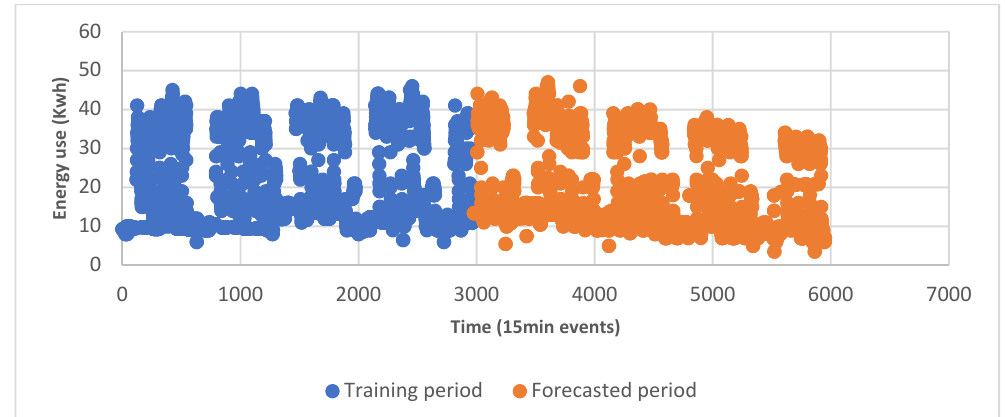
Figure A2. Building energy use over the summer training and testing period.